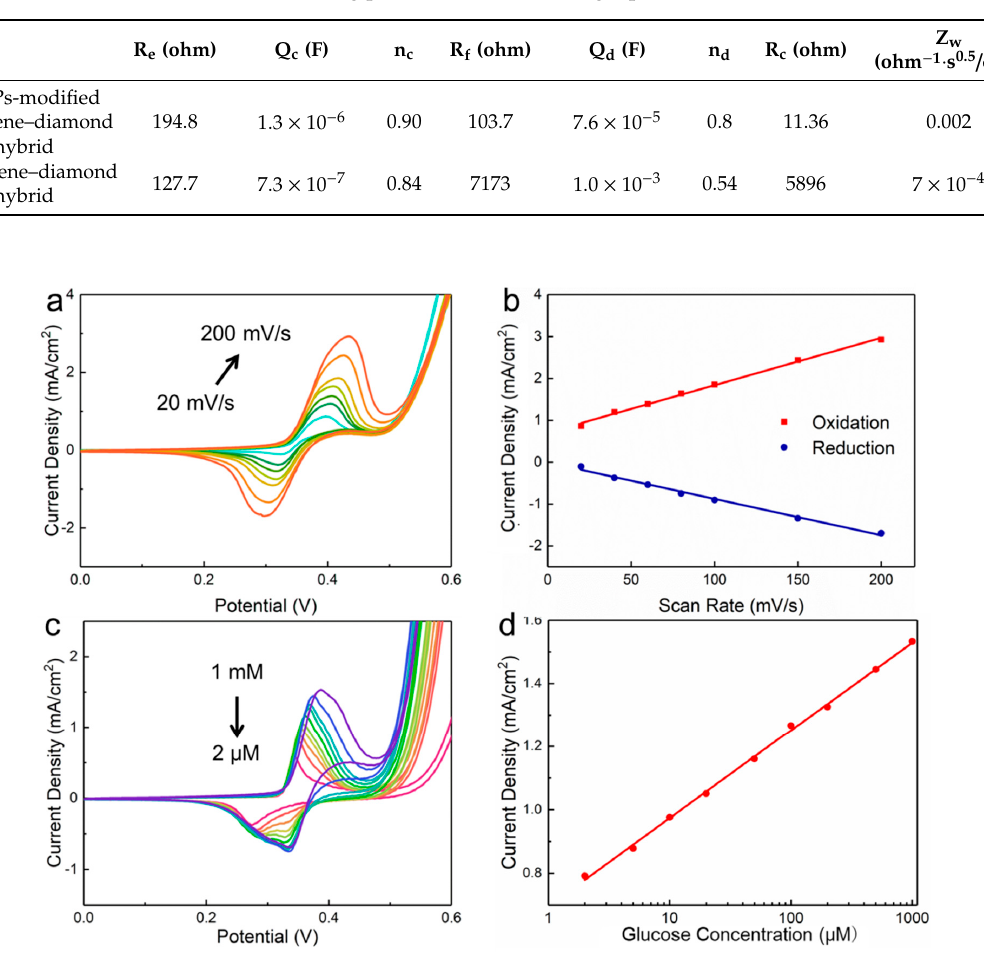
Figure 4. ( a ) CV responses of Ni NPs-modified graphene–diamond hybrid electrodes for glucose detection as a function of various scan rates (from inner to outer curves): 20, 40, 60, 80, 100, 150, and 200 mV s − 1 in 0.5 M NaOH electrolyte containing 5 mM glucose and ( b ) the corresponding current density of oxidation and reduction peaks. ( c ) CV responses of Ni NPs-modified samples in 0.5 M NaOH electrolyte containing different glucose concentrations at a scan rate of 100 mV s − 1 . ( d ) Current density of devices as a function of glucose concentration.